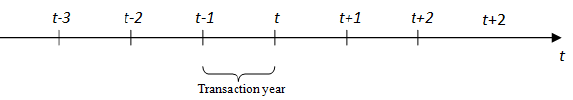
Fig. 1. Time line for the